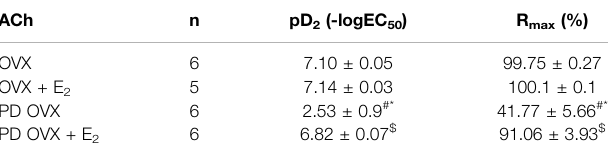
TABLE 1 | Sensitivity (pD 2 : logEC 50 ), and Maximum Response (R max ) to acetylcholine (ACh) in mesenteric arteries from ovariectomized (OVX) and E 2 treated (OVX + E 2 ) control and prediabetic (PD)